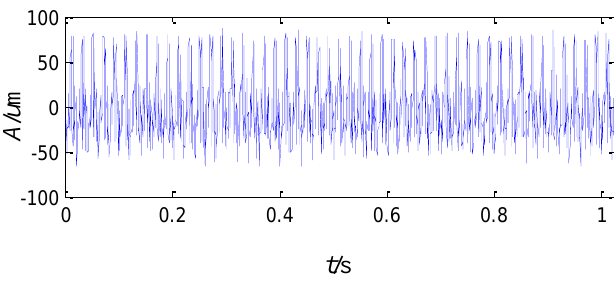
Figure 5. The waveform of the sensor-dependent vibration signal in time